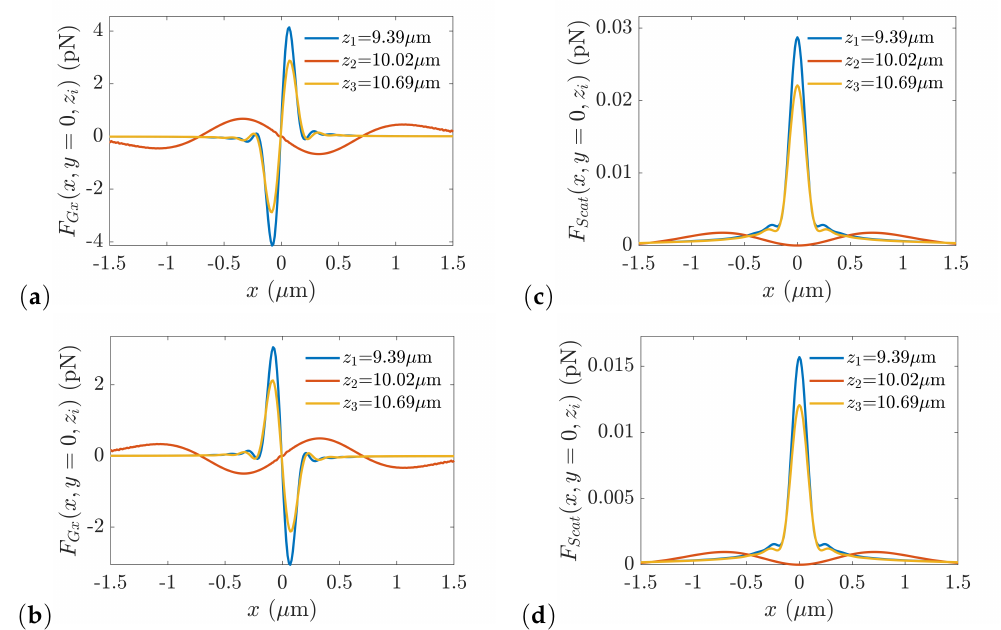
Figure 9. ( a ) x -component of the gradient force for n 1 = 1 and ( b ) for n 1 = 1.59, and ( c ) scattering force for n 1 = 1 and ( d ) for n 1 = 1.59. In all cases, n 2 = 1.33. Other parameters are the same as in Figure